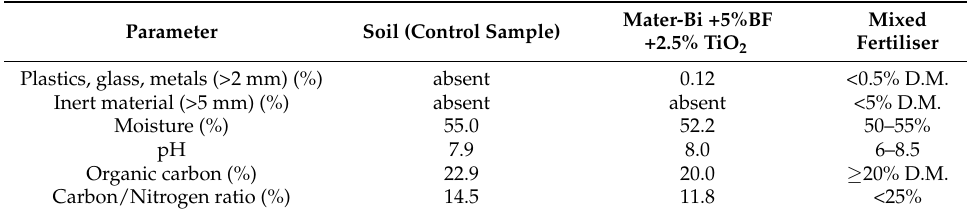
Table 19. Analysis of mixed fertiliser.